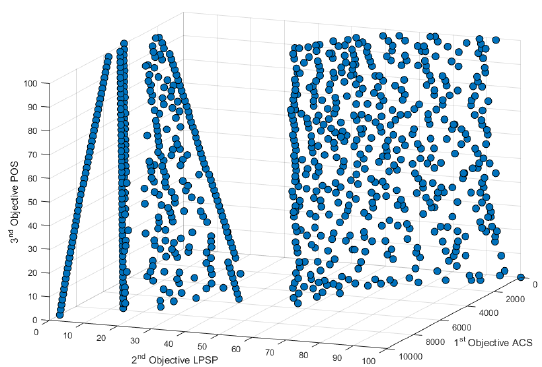
Figure 11. The PF obtained after 51 times of algorithm